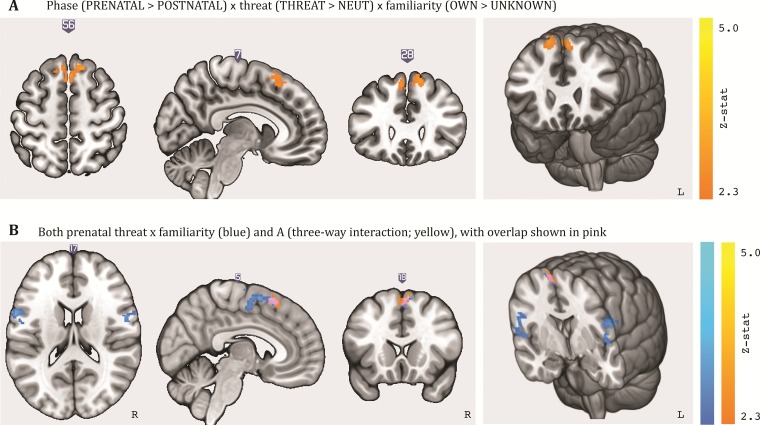
Activation for (A) three-way interaction phase × threat × familiarity, where the interaction effect between threat and familiarity was stronger in the pre-natal compared to post-natal session, and (B) both the three-way interaction and the pre-natal threat × familiarity interaction (see also Figure 2B) overlaid on standard brain. Results (cluster-thresholded at 2.3, P < .05) are displayed on MNI-normalized template brain (i.e. mni152_2009bet.nii) using MRIcroGL software.